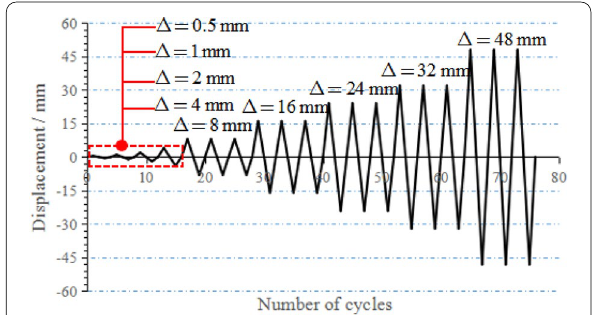
Fig. 22 Loading program of FEM